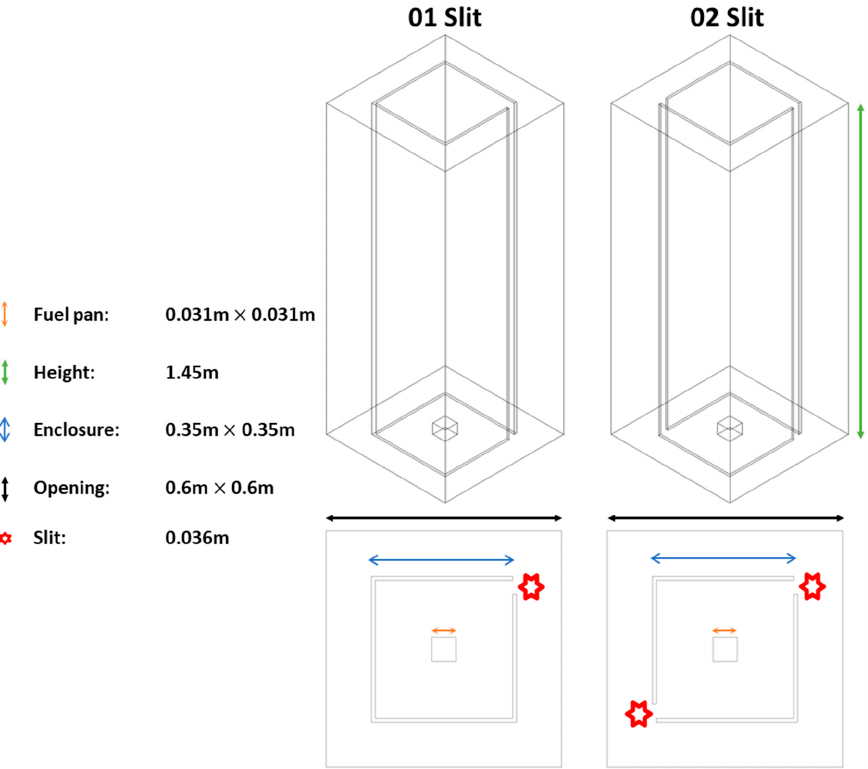
Figure 1. Geometric features of the computational domain.